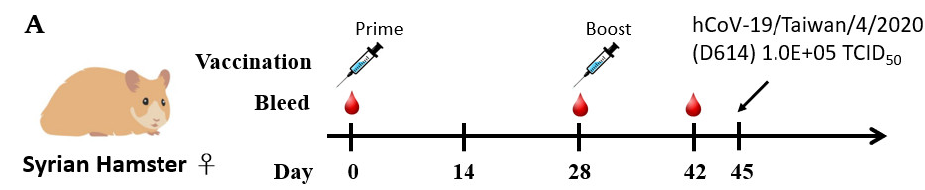
Figure 6. Cytokine production by spike-stimulated splenocytes from vaccinated mice BALB/c ( A ) and C57BL/6 ( B ) mice ( n = 3–4/group) were administered PBS as a control or 0.5 μg or 5 μg or 20 μg of S-Trimer protein with or without adjuvant (Alum or SWE) via intramuscular (IM) injection twice on Day 0 and 28. Splenocytes were collected at two weeks from the second vaccination and incu- bated with SARS-CoV-2 S ectodomain to restimulate cytokine secretion. The secretion level of Th2 cytokine (IL-13, IL-5, and IL-4), and Th1 cytokine (IFN-γand IL-2) was evaluated by indirect ELISA. The Th1/Th2 ratio was calculated from each producing amount of IFN-γ and IL-4. Each symbol represents the cytokine value from an individual mouse; each group of cytokines’ value was pre- sented as the mean ± SD. Statistical analysis of all comparisons was made by two-tailed Mann– Whitney tests. * p < 0.05 was considered